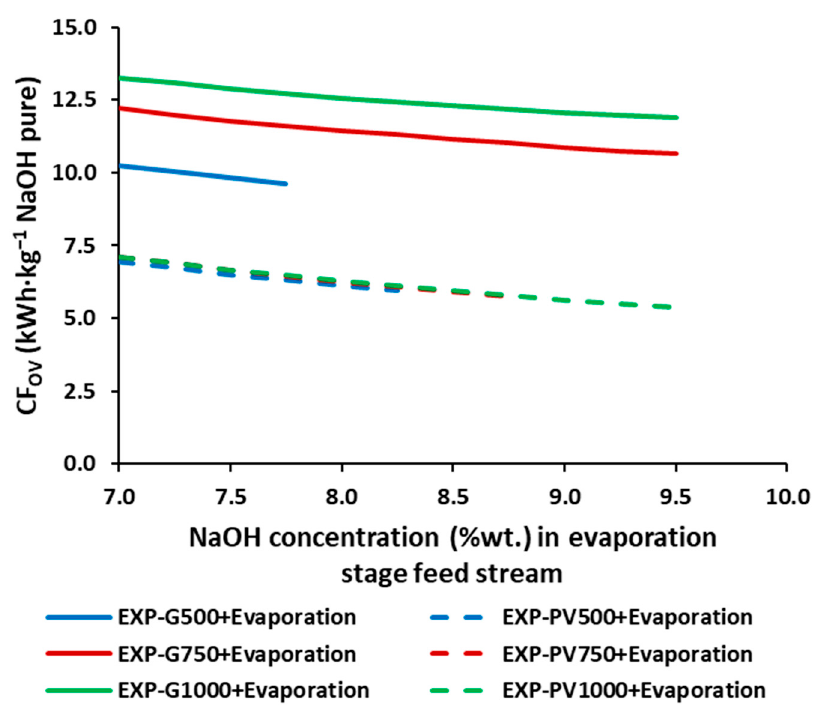
Figure 5. CF OV for the different NaOH concentrations in the feed of the stream of the simulated triple effect evaporation.